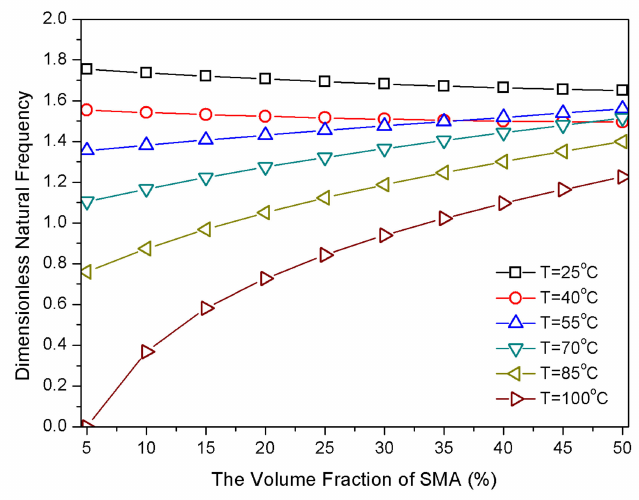
Figure 9. Dimensionless natural frequencies vs. the SMA volume fraction subjected to di ff erent temperatures.